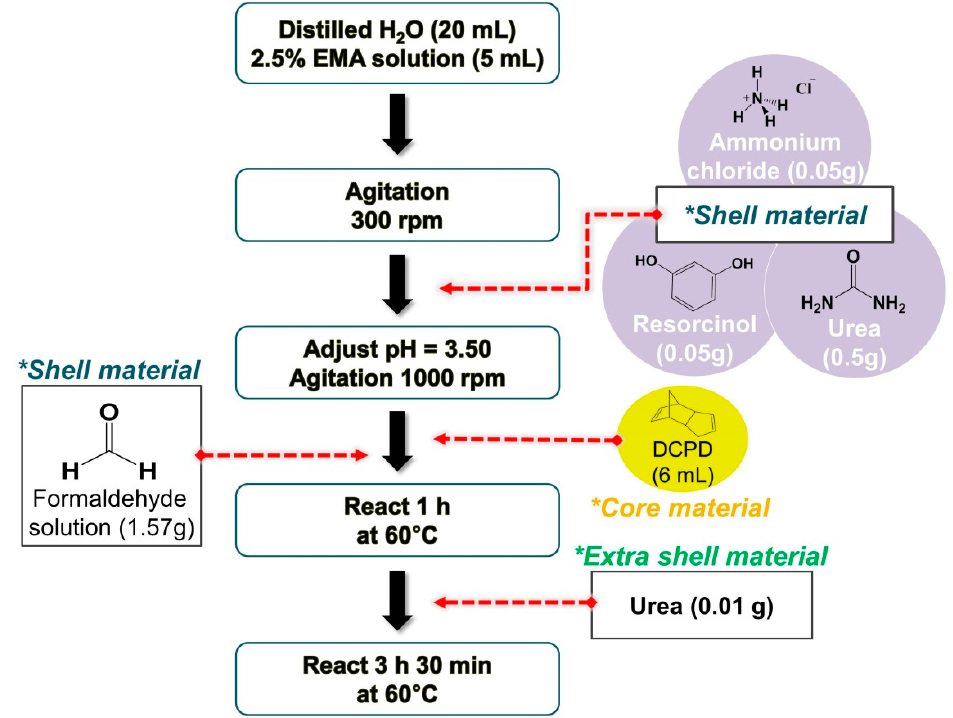
Figure 1. Synthesis flow chart of the mechanically-enhanced urea-formaldehyde (UF) microcapsules using multi-step in situ polymerization.